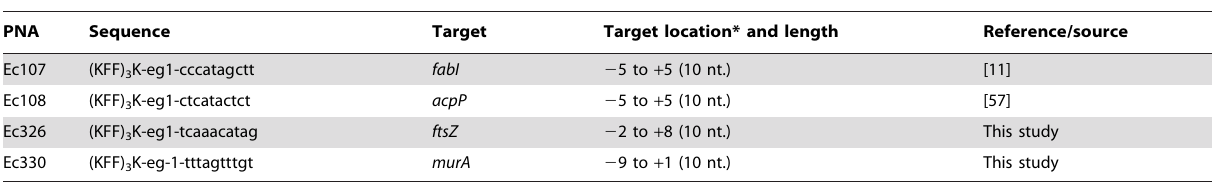
Table 1. Properties of PNA used in this